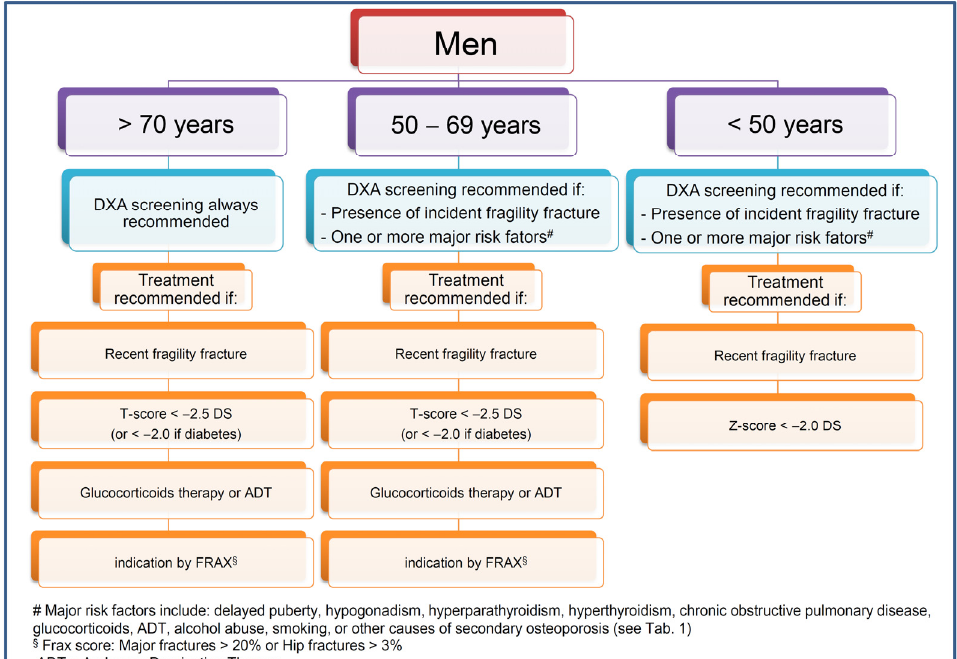
Figure 1. Proposed indications for DXA screening and treatment in men.